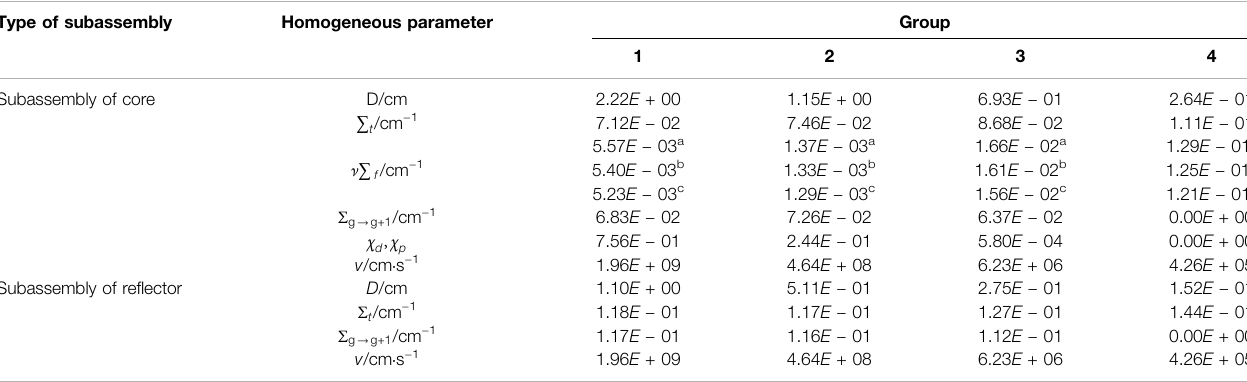
TABLE 1 | Homogeneous parameters of core and re fl ector in ADSR. Type of